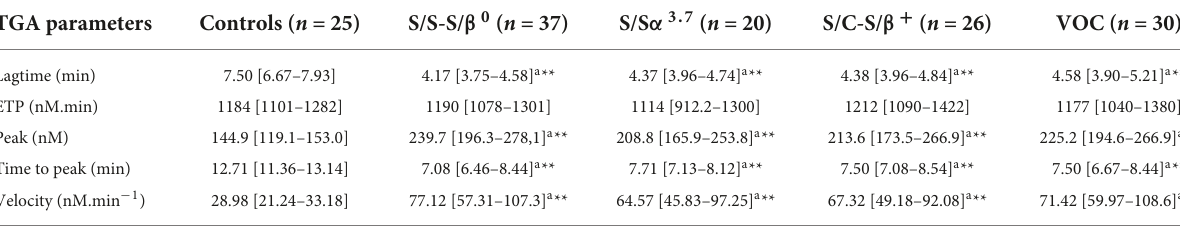
TABLE 3 Comparison of TGA parameters between patients and controls.